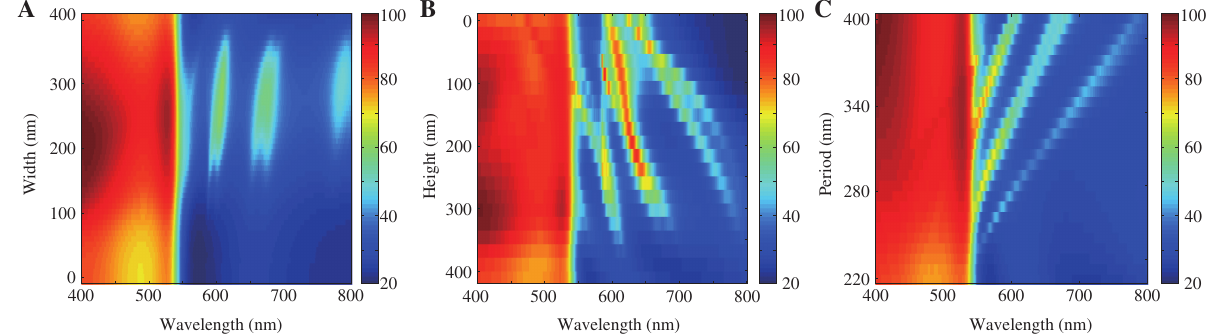
Figure 3: Variation in the absorption spectra of the HOIP metamaterials as a function of the structural geometries. (A) Absorption spectra as a function of w , while t = 290 nm, d = 100 nm, and p = 400 nm. (B) Absorption spectra as a function of d for t = 290 nm, w = 220 nm, and p = 400 nm. (C) Absorption spectra as a function of p for t = 290 nm, w = 220 nm, and d = 100